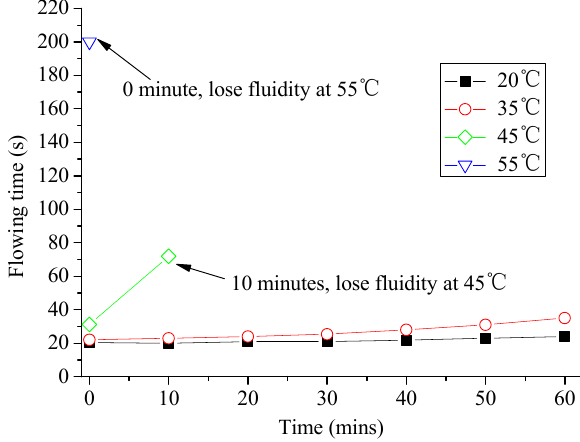
Figure 6. Effects of temperature on fluidity of CAM I paste. Figure 6. E ff ects of temperature on fluidity of CAM I